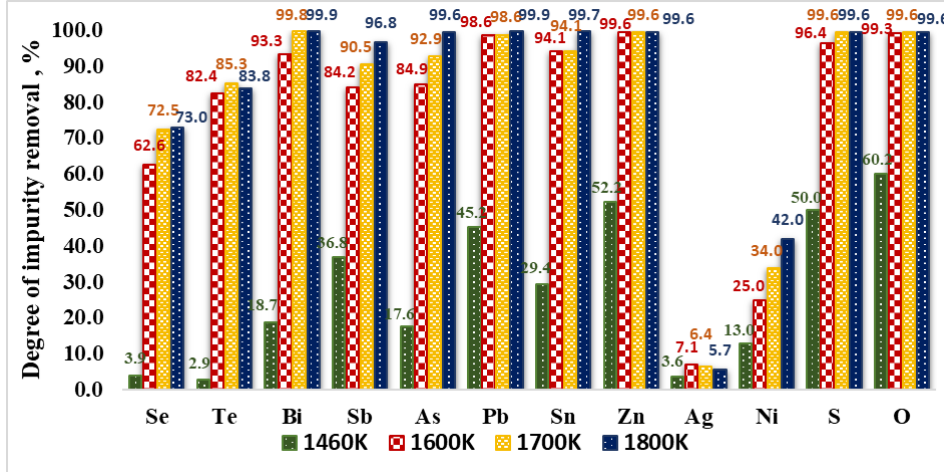
Figure 5. Influence of the temperature on the removal of impurities from copper technogenic material at EBMR.